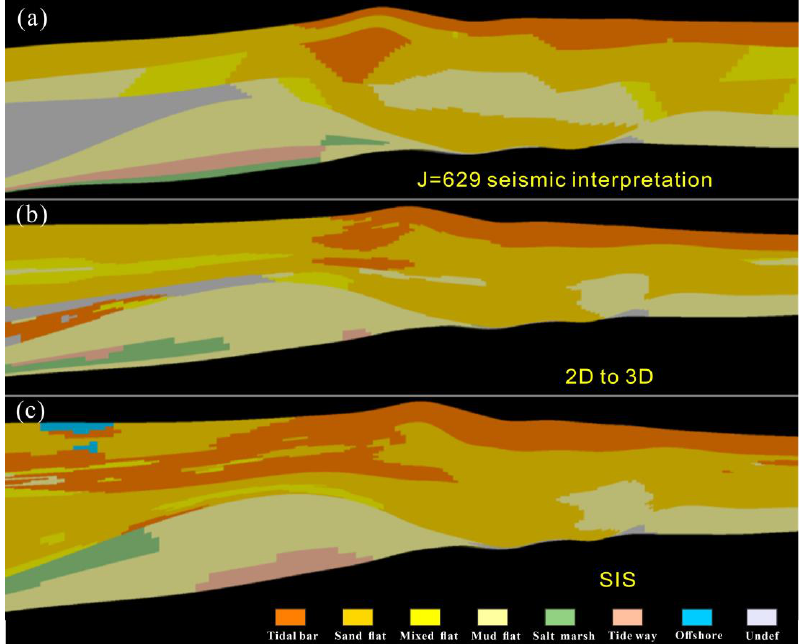
Figure 14. Comparison of seismic interpretation section and prediction results. ( a ) The seismic interpretation section in the direction of J=629; ( b ) the prediction result of 2D to 3D. ( c ) the prediction result of SIS.